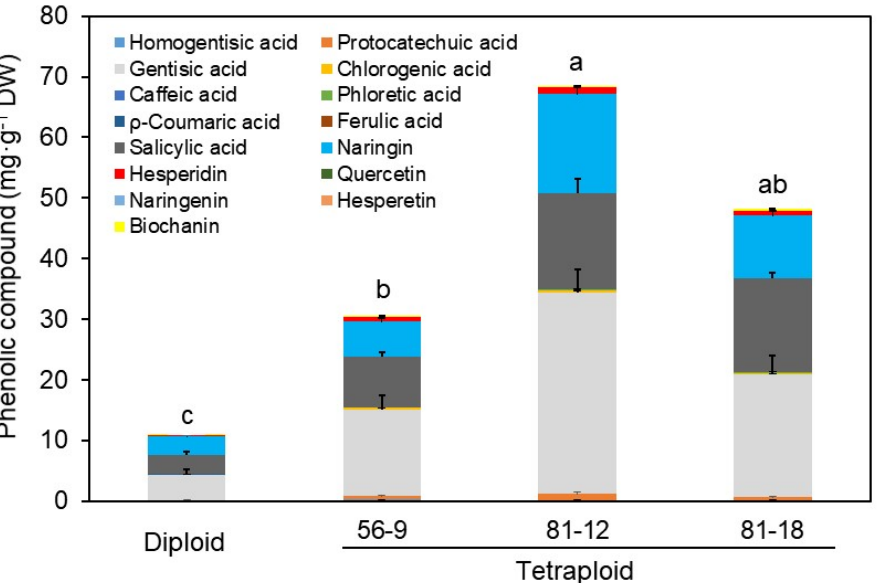
Figure 5. HPLC analysis of the contents of various phenolic compounds in whole plants of diploid and three tetraploid lines (56-9, 81-12, and 81-18) after 3 month of ex vitro cultivation in C. officinale . Different lowercase letters above the bars indicate significant differences ( p < 0.05; Duncan’s multiple range test).